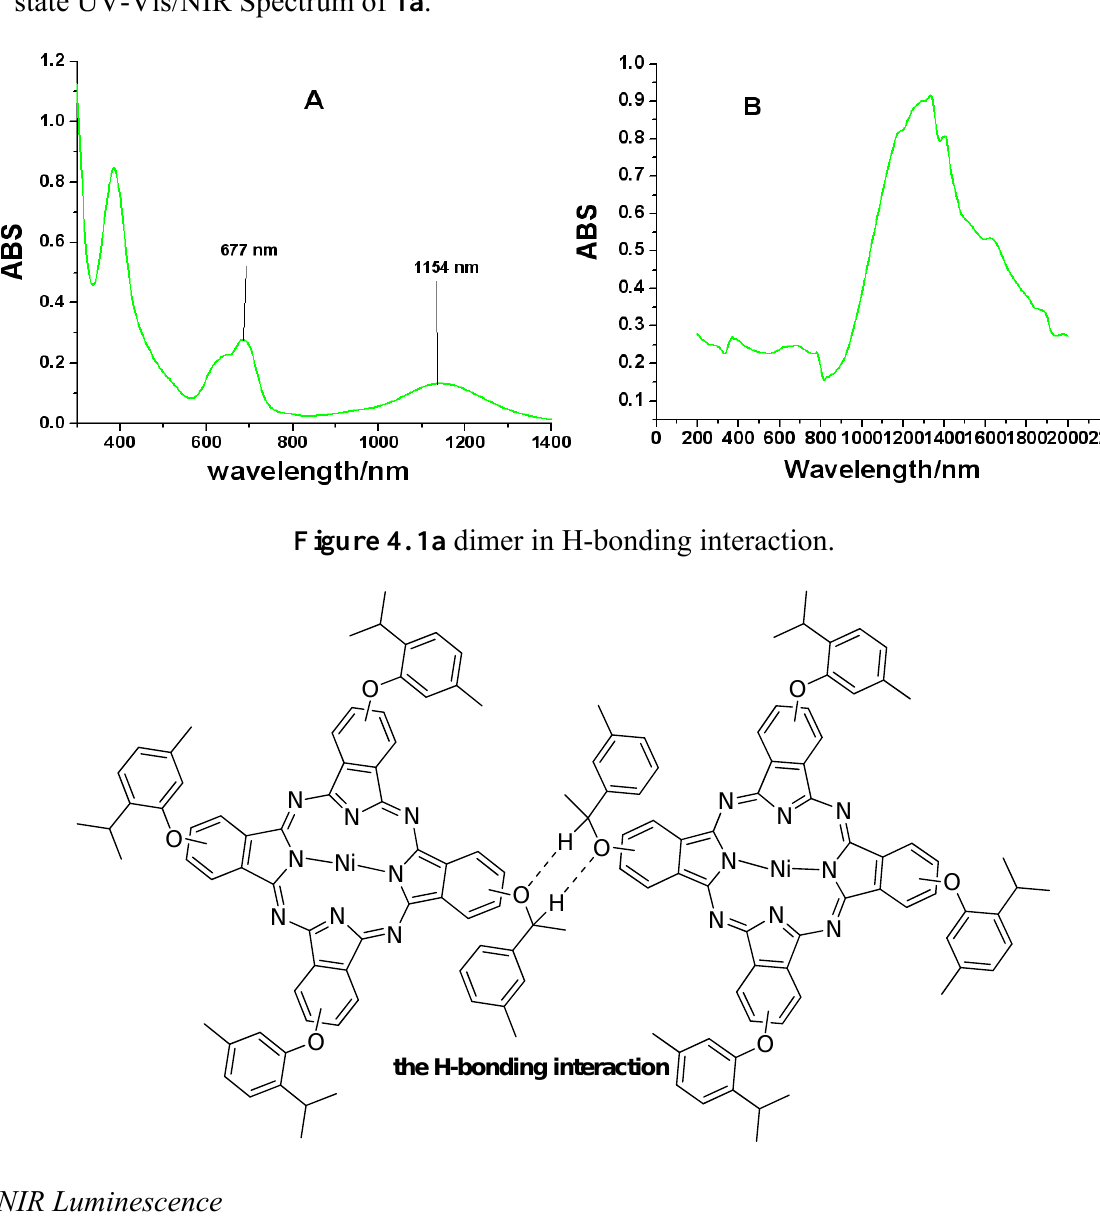
(1.0 × 10 − 4 mol/dm 3 ) and ( B ) Solid 3